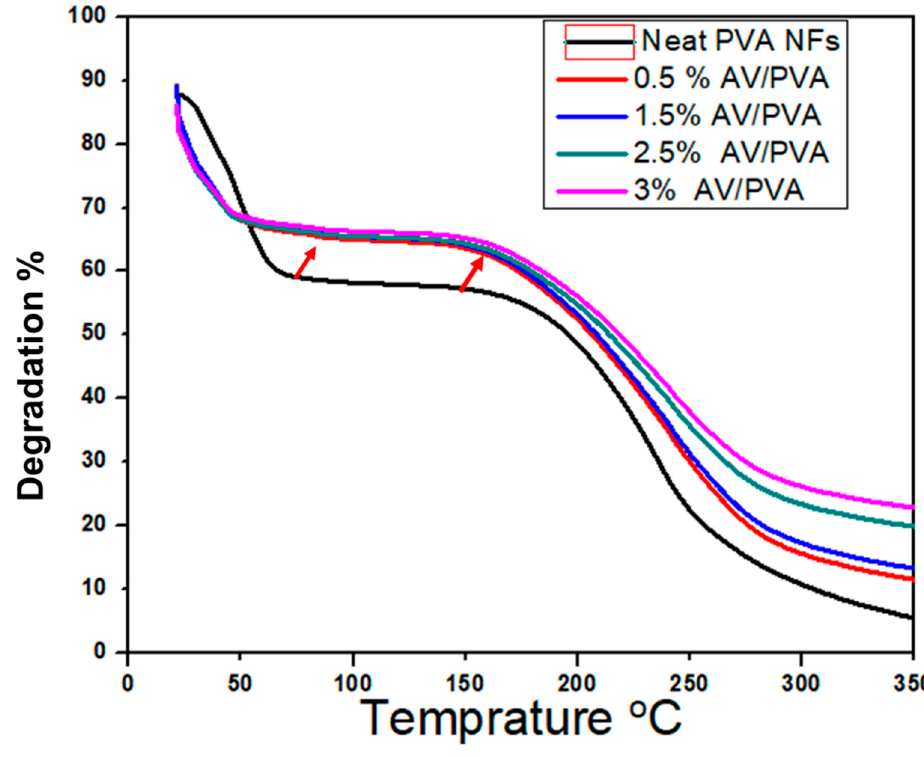
Figure 9. TGA spectra of neat PVA and AV/PVA nanofibers.